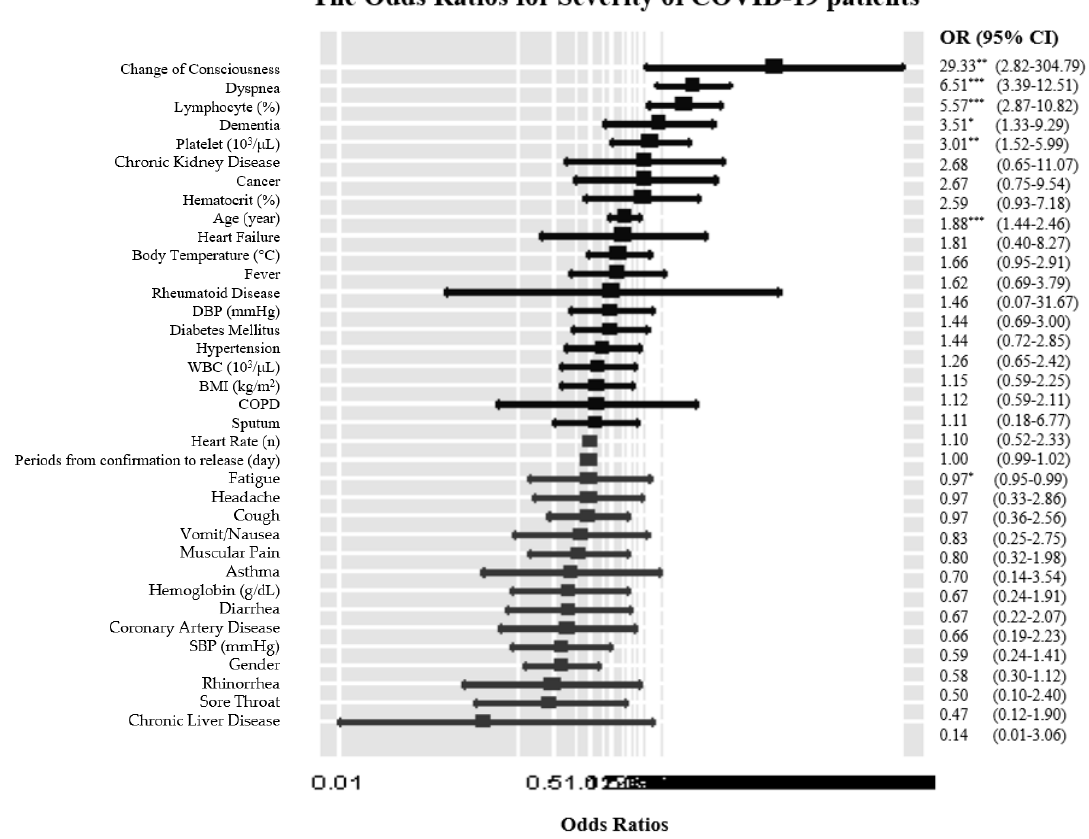
Figure 1. The Odds Ratios for Severe COVID-19 patients. * ( p < 0.05), ** ( p < 0.01), *** ( p < 0.001), BMI (Body Mass Index), SBP (Systolic Blood Pressure), DBP (Diastolic Blood Pressure), COPD (Chronic Obstructive Pulmonary Disease, OR (odds ratio), CI (confidence interval), WBC (white blood